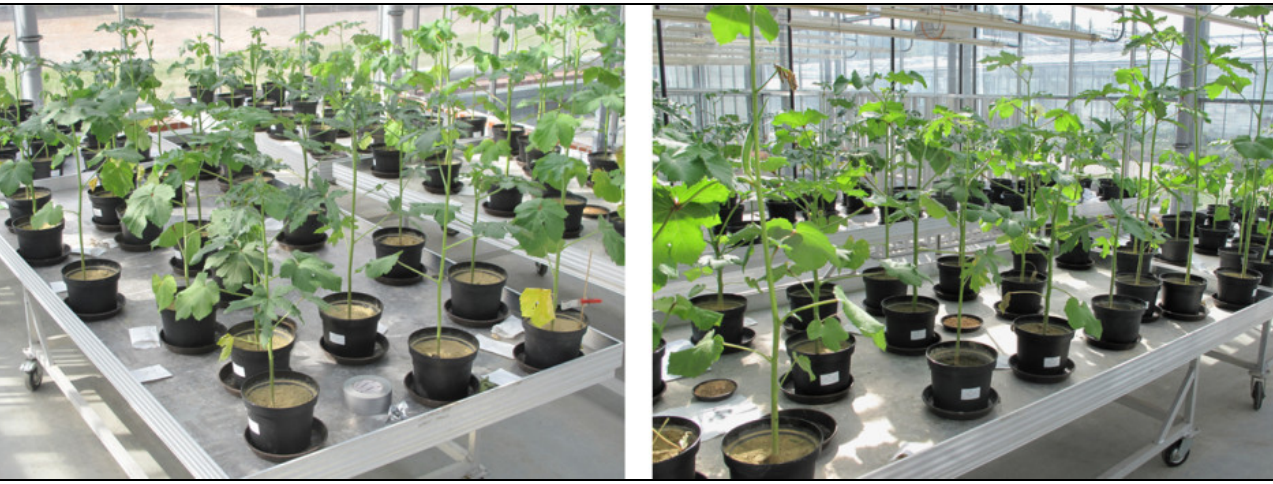
Figure A2. Greenhouse experiment (okra plants in a randomized design on tables inside the greenhouse).